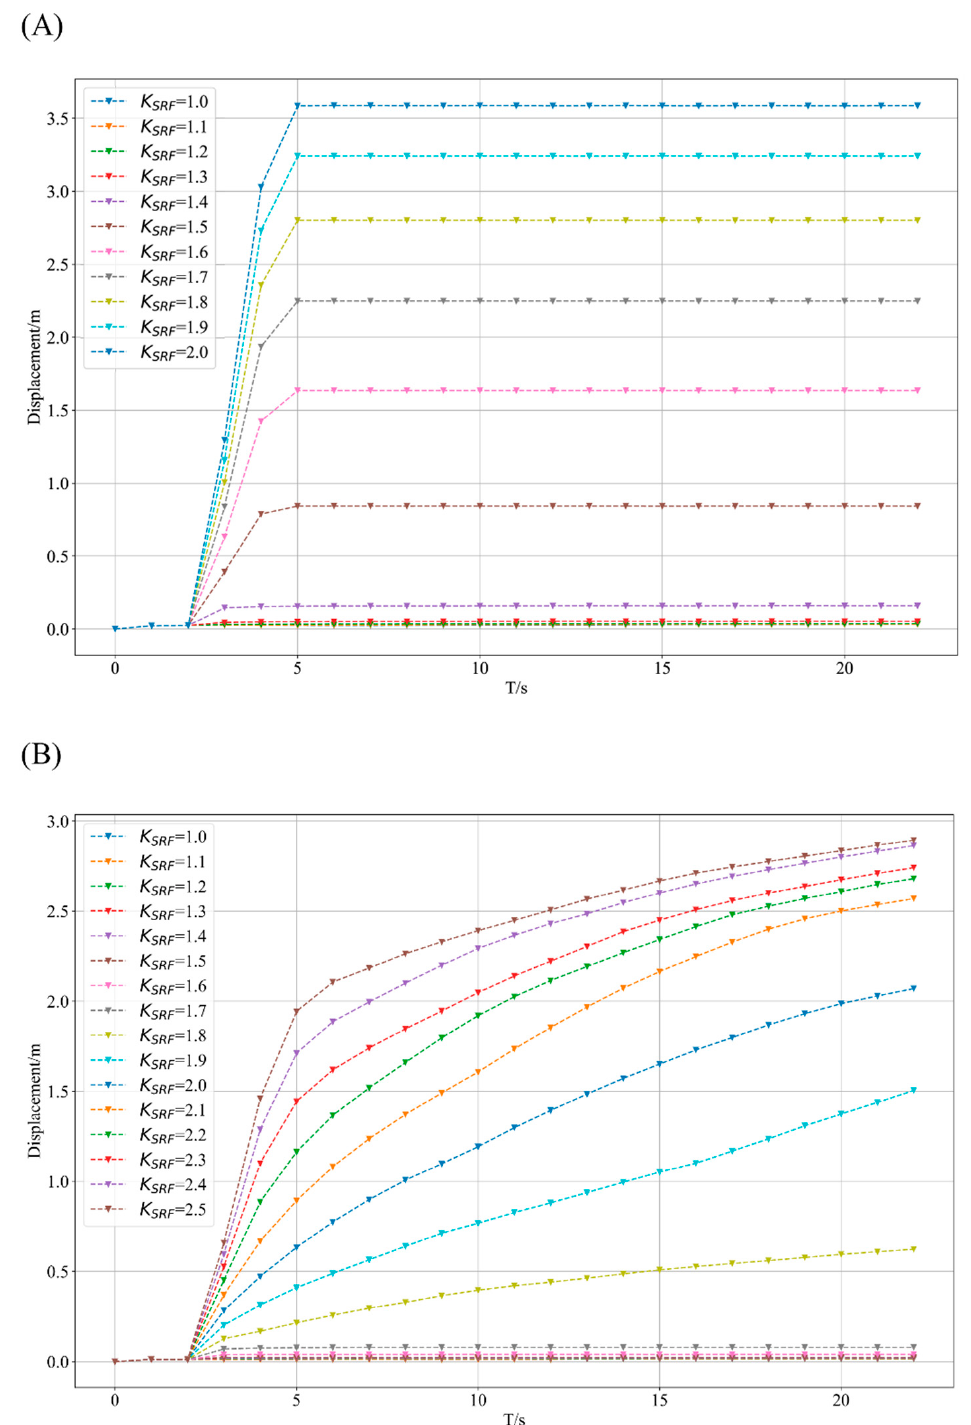
Figure 4. Curves of the maximum displacement of the slope over time for different reduction factors. ( A ) Maximum displacement variation curve for pure soil slopes; ( B ) Maximum displacement variation curve for SRM slopes.